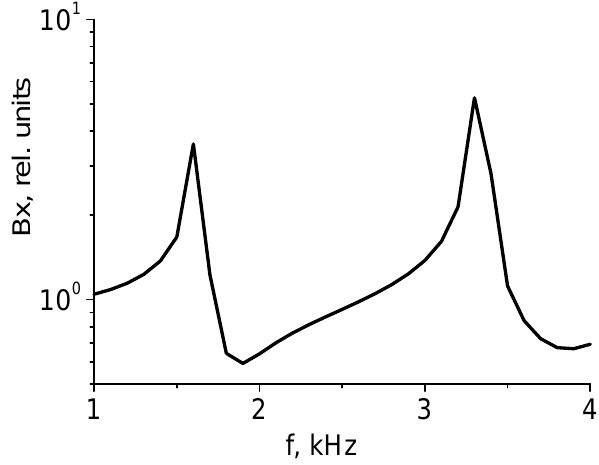
Fig. 7. Amplitude spectra of transverse resonance of the Earth- ionosphere cavity when excited by the infinite planar in-phase cur- rent placed at the 7km altitude above the ground in the ambient night conditions. The amplitude maxima are observed at transverse resonance frequencies of 1.6 and